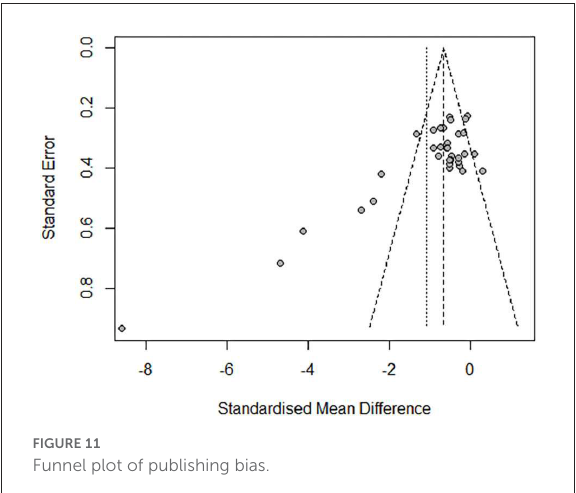
FIGURE11 Funnel plot of publishing